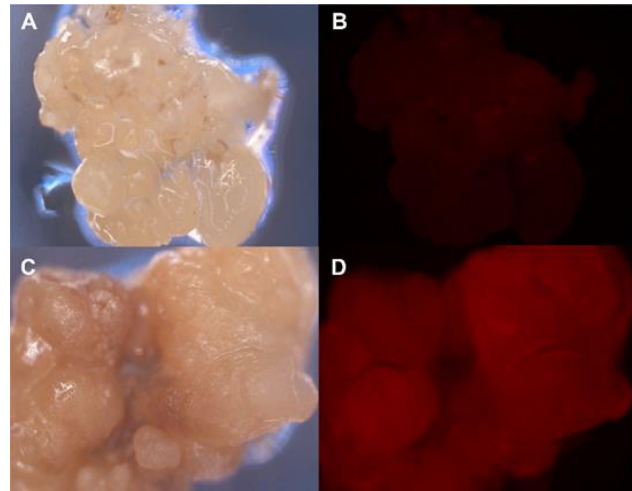
Figure 3. Red fluorescence in olive embryogenic callus transformed with the DsRed marker gene. ( A , B ) Control non-transformed callus. ( C , D ) DsRed transformed embryogenic callus. Pictures were taken under white light ( A , C ) and fluorescent light using a DsRed excitation filter ( B , D ).